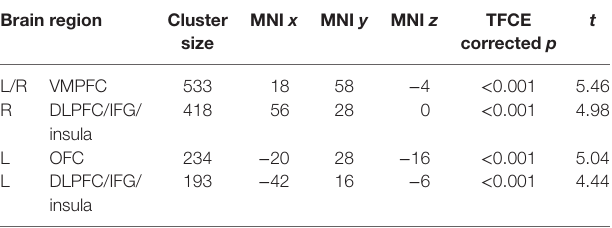
TaBle 2 | Summary of VBM results (Controls > Betel quid